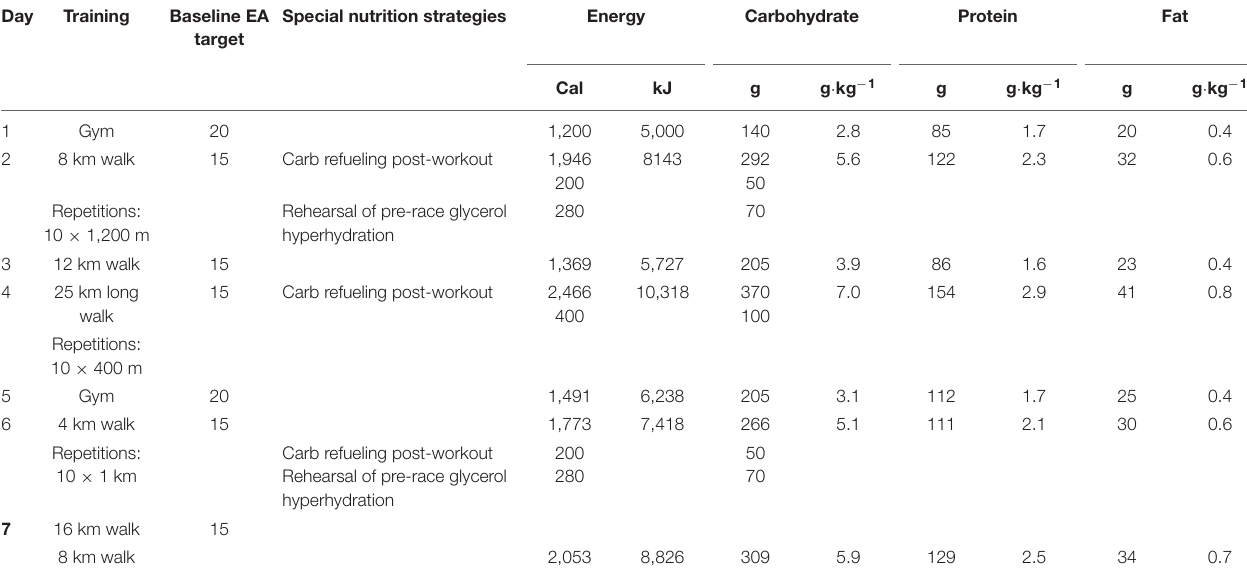
Sports drink volume (mL)